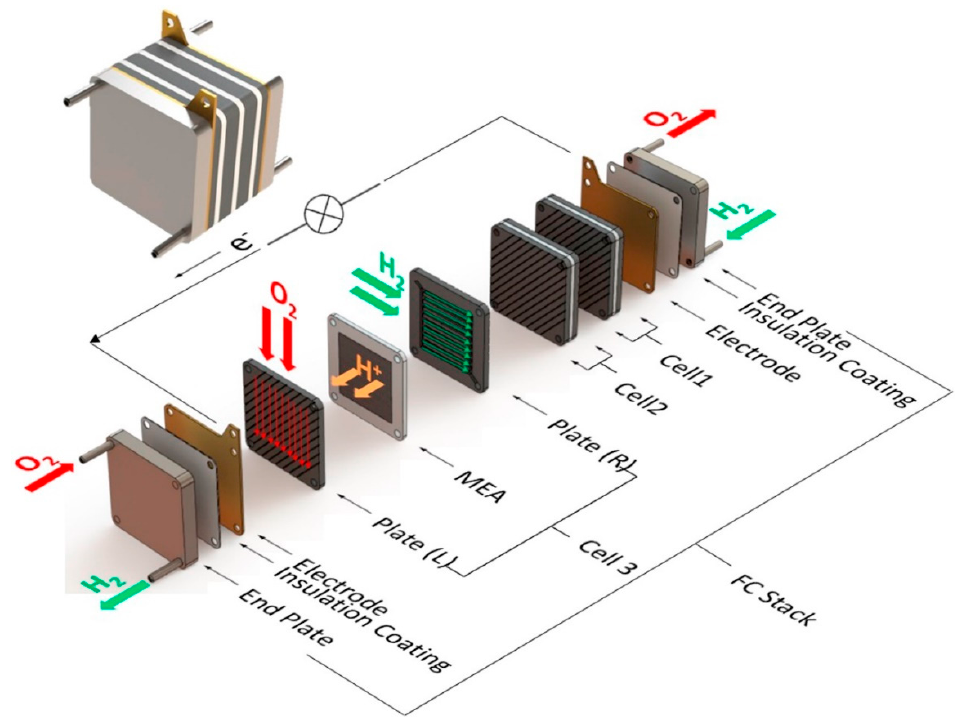
Figure 14. Schematic of a fuel cell stack, and its components [158].